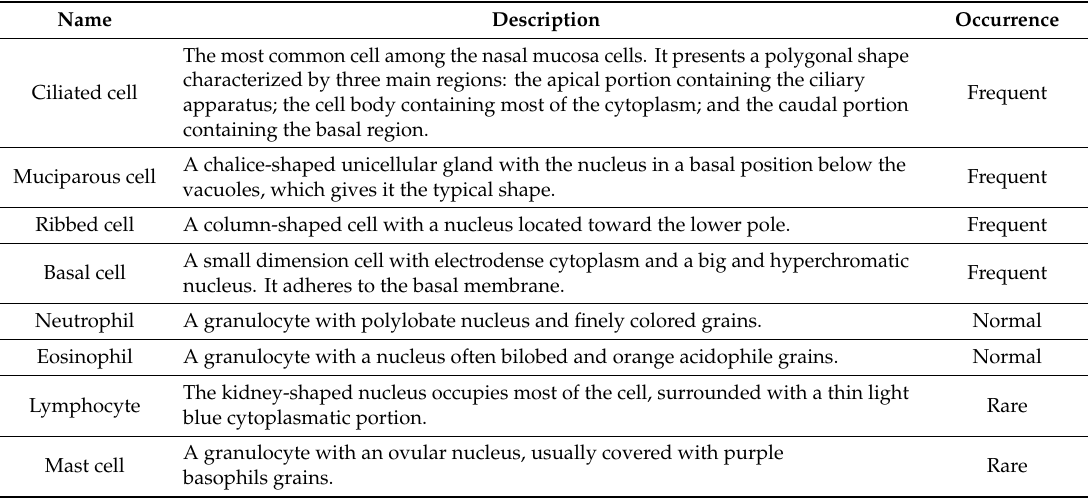
Table 1. Cell types of the nasal mucosa, useful to diagnose rhinitis and nasal diseases.